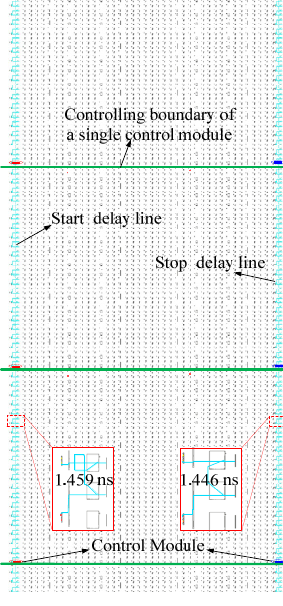
Figure 6. Place and route of the proposed DTC based on programmable delay lines (PDLs).